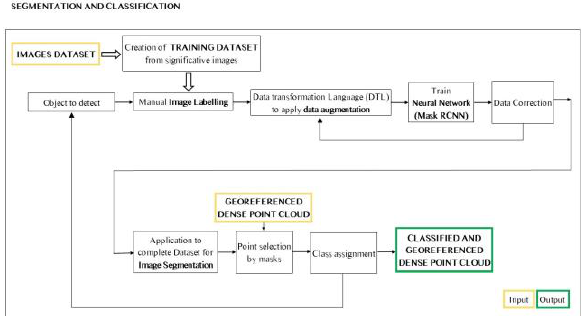
Figure 4. Workflow for image segmentation using Mask-RCNN